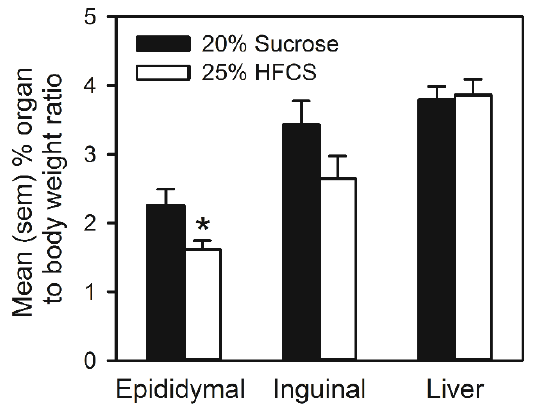
Figure 7. Mean (SEM) percent organ to body weight ratio of epididymal fat pads, inguinal fat pads, as well as whole livers in rats that self-administered 25% HFCS or 20% sucrose in home cages. * Significant difference between